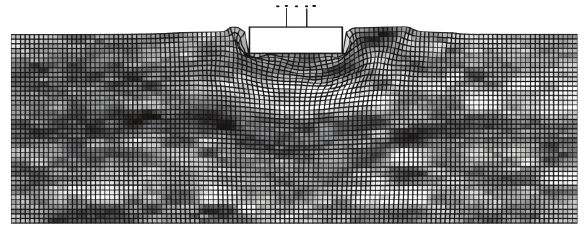
Fig. 6. A realisation of cohesion random field